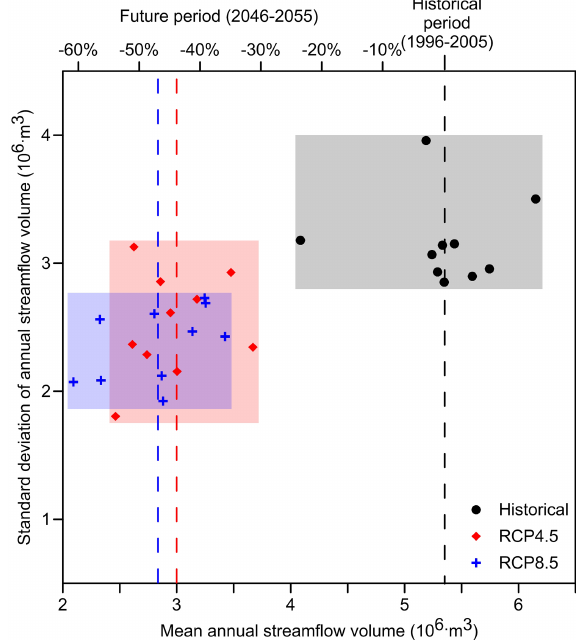
Figure 6. The standard deviation of the annual rainfall of each 30- year ensemble selected from the 300-year simulation (black for his- torical, red for RCP4.5 scenario and blue for RCP8.5 scenario) is presented vs. the mean annual rainfall for each ensemble. Dashed lines represent the average annual rainfall of each ensemble, and colored boxes show the extent of annual rainfall mean and standard deviation for the different periods and scenarios. The rainfall en- sembles represent upper Dalya and upper Taninim catchments com- bined.